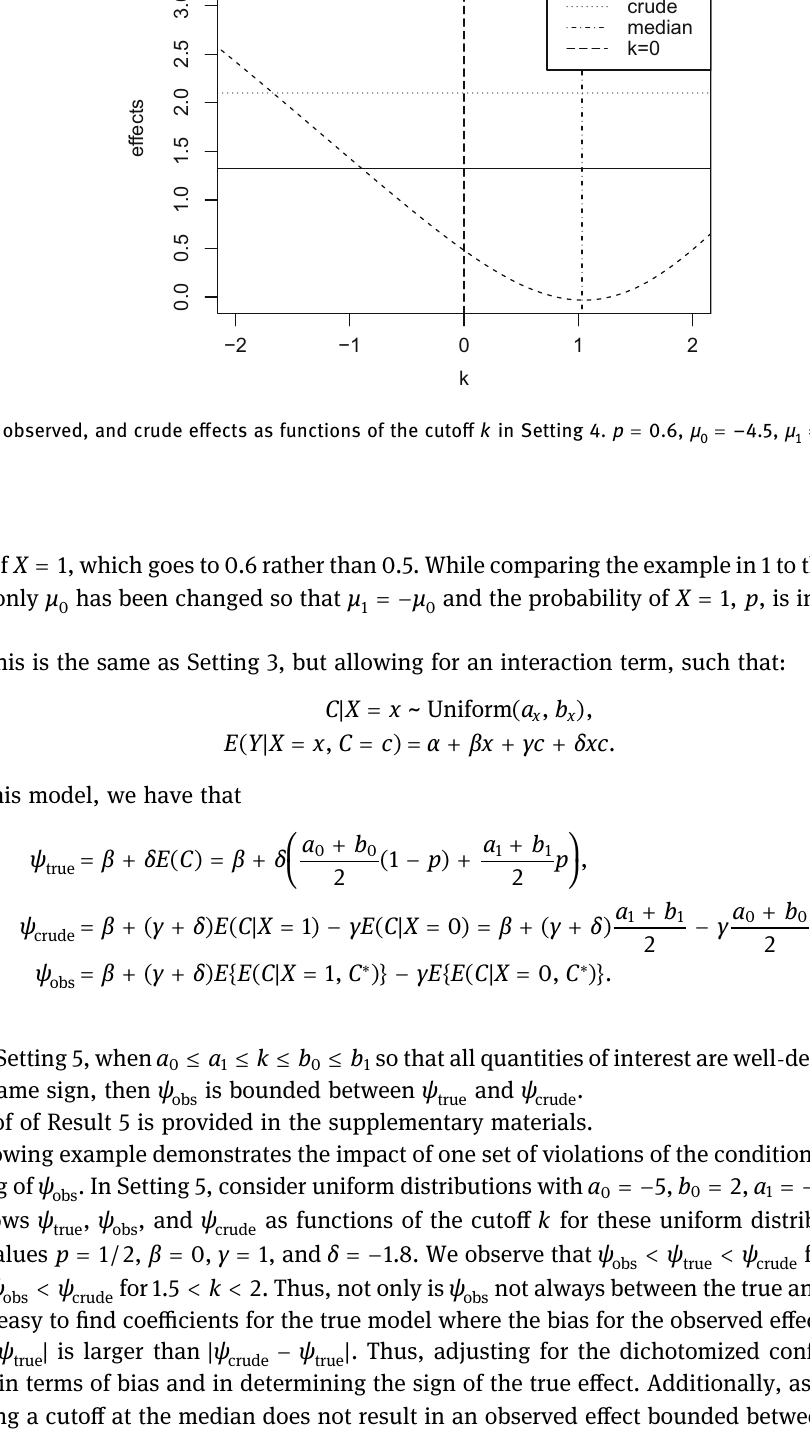
Figure 4 using a cuto ff at the median does not result in an observed e ff ect bounded between the true and crude e ff ects.